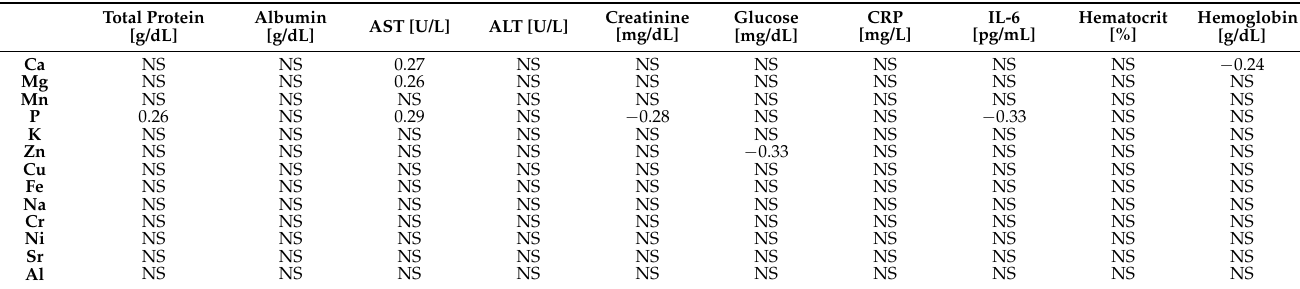
Table 3. Spearman rank